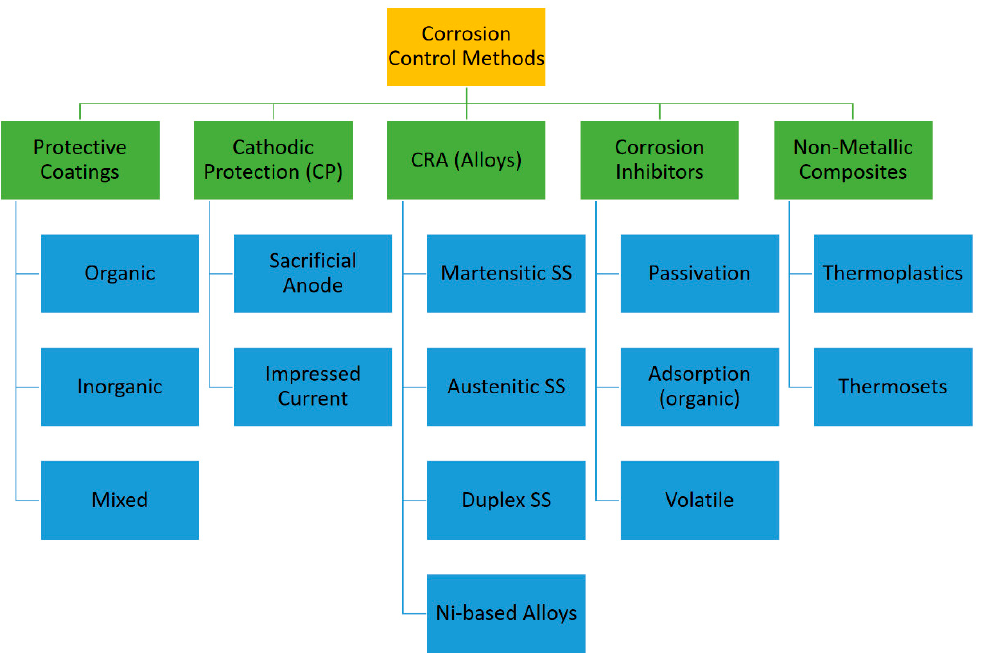
Figure 2. Summary on corrosion control methods.